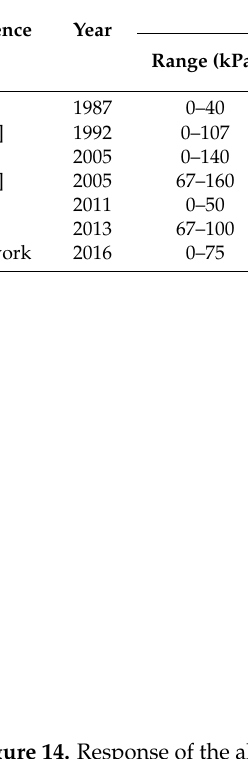
Table 2. Performance comparison of the selected multi-sensor MEMS chips capable of measuring pressure, temperature and flow rate. Ref.